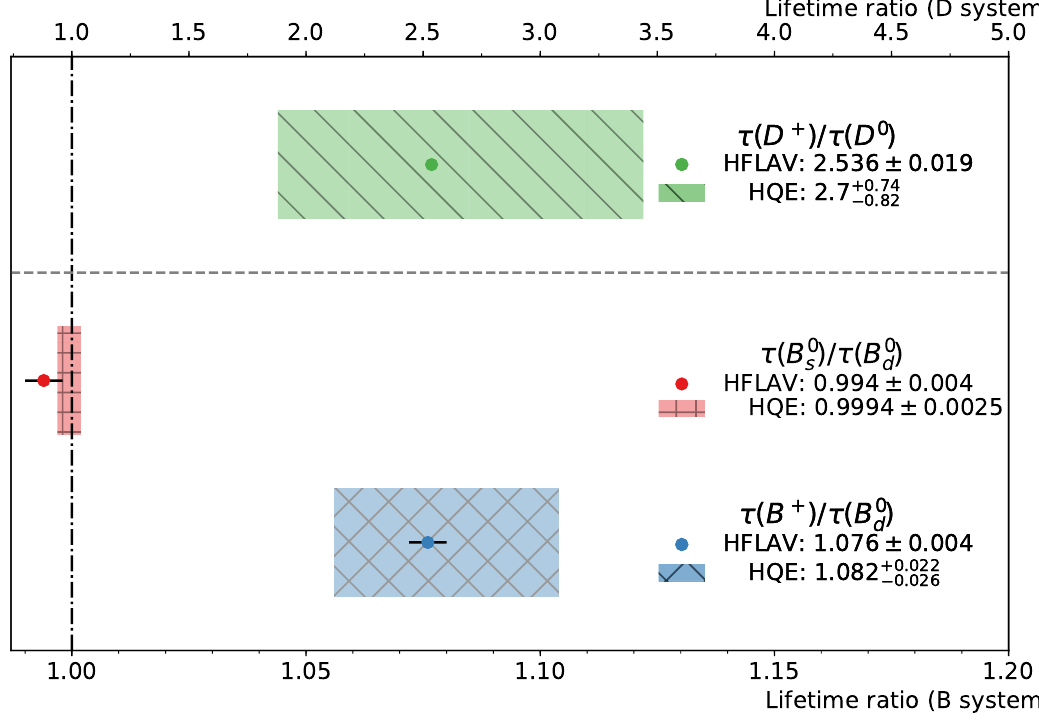
B Q and the matrix element R 0 and the values given B q i h i